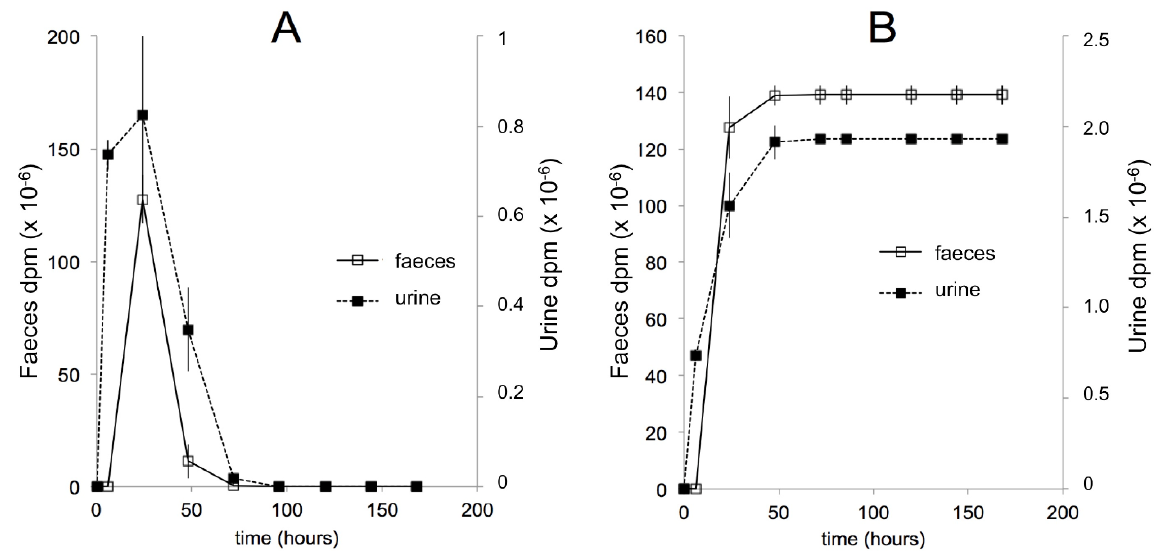
Figure 8. Comparison of the temporal ( A ) and cumulative ( B ) urinary and fecal elimination of radioactivity after the oral application of [5,7,9- 3 H]20E to 6–7 week-old male Wistar rats. After oral application of [ 3 H]20E, elimination of radioactively labelled 20E and its metabolites is completed within 48 h. The amount of radioactivity recovered from the feces is by far the major route of excretion, since the amount in the urine corresponds to only 1.40% of the total radioactivity recovered. (Reproduced, with permission, from [127]).